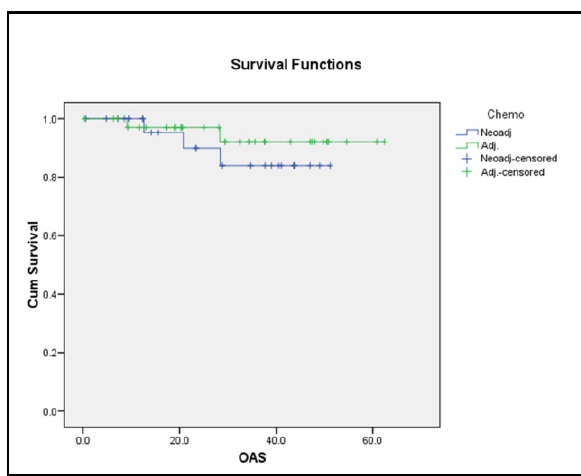
Figure 3: Kaplan-Meier curves of estimated overall survival of patients who received adjuvant